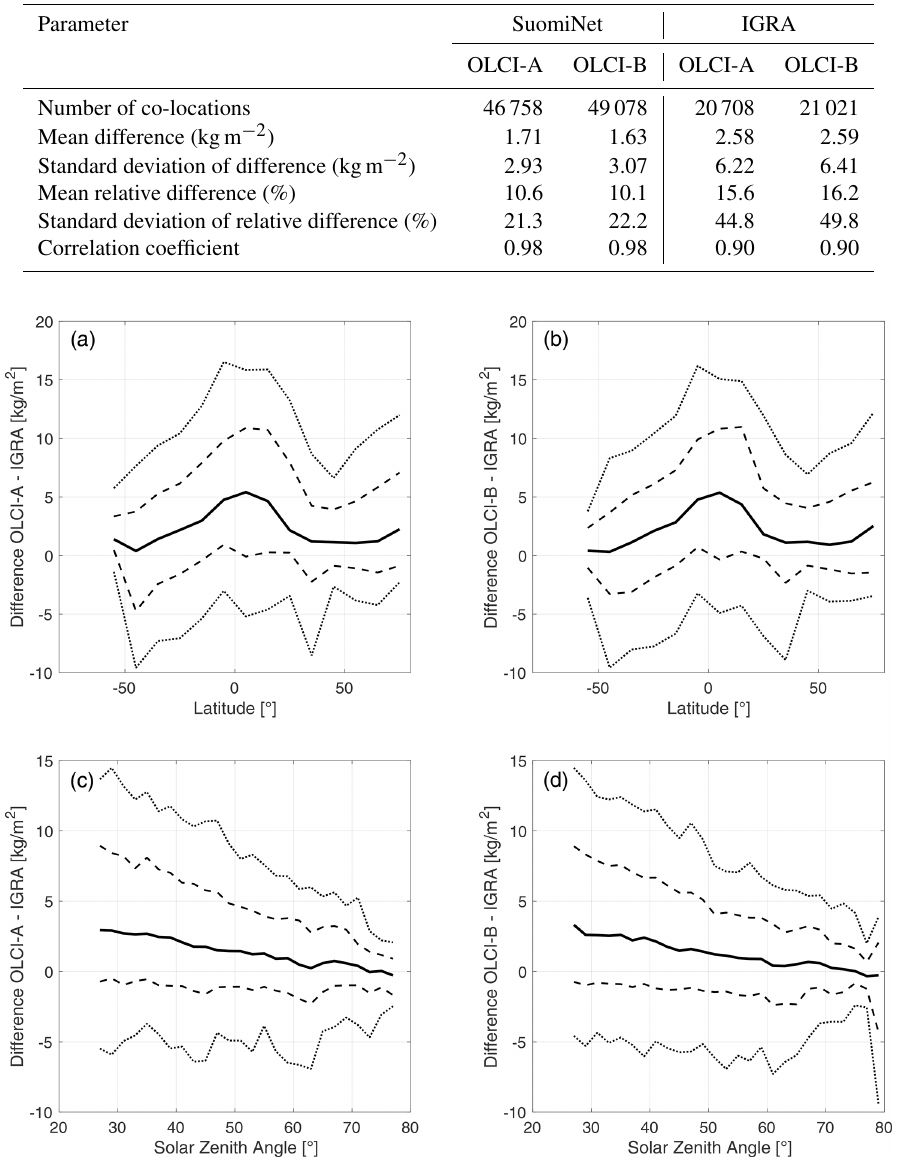
Figure 5. Difference OLCI-A (a, c) and OLCI-B (b, d) of observations against IGRA as a function of latitude (a, b) and solar zenith angle (c, d) . The solid line shows the median of each 2 ◦ wide bin, while the dashed lines show the 16th and 84th percentiles and the dotted lines the 5th and 95th percentiles. Bins with fewer than 20 matchups were omitted from the figure.